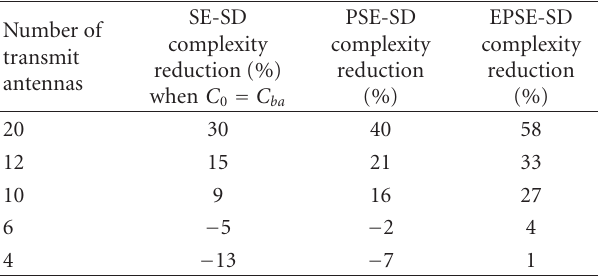
Table 1: Reduction in complexity corresponding the number of transmit antennas.